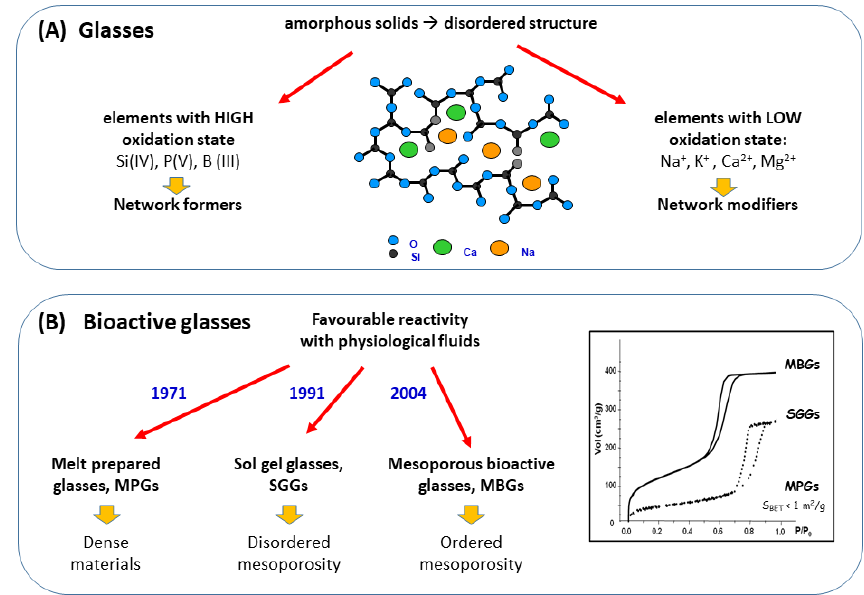
Figure 1. Main features of: ( A ) glasses and ( B ) the three families of bioactive glasses. The textural properties, i.e., surface area and pore volume, of the three families of